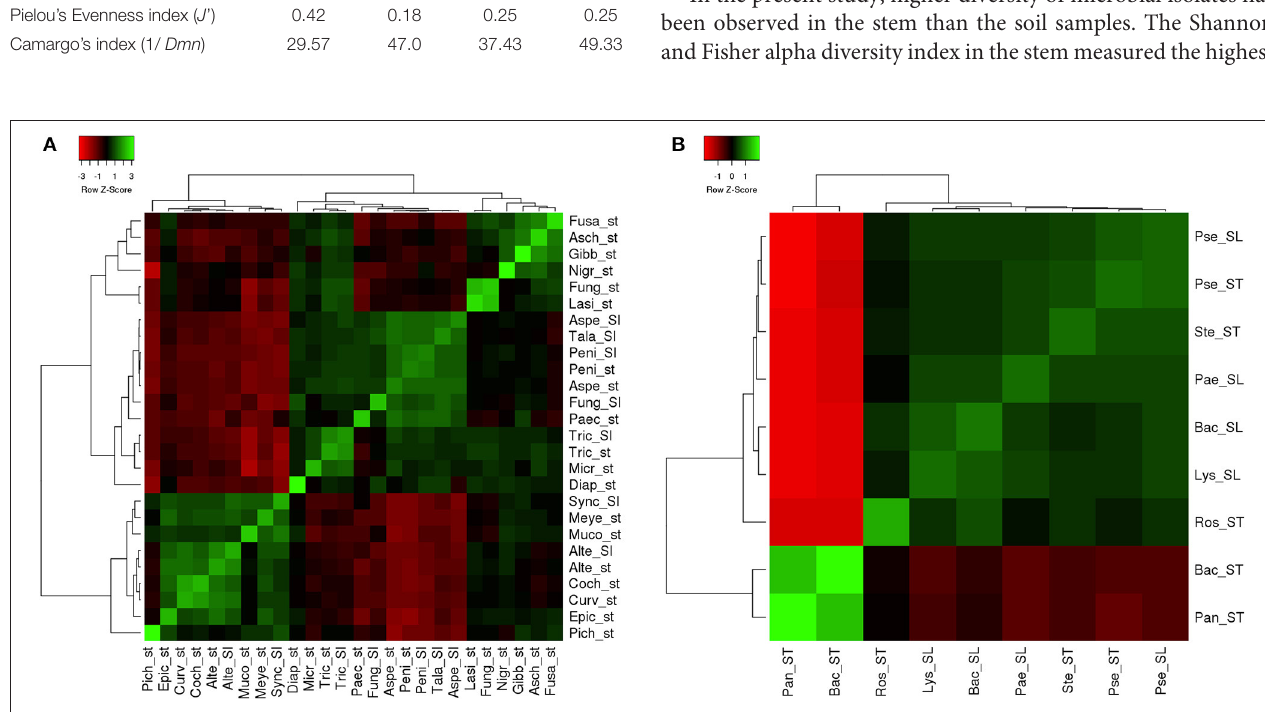
Frontiers in Microbiology |